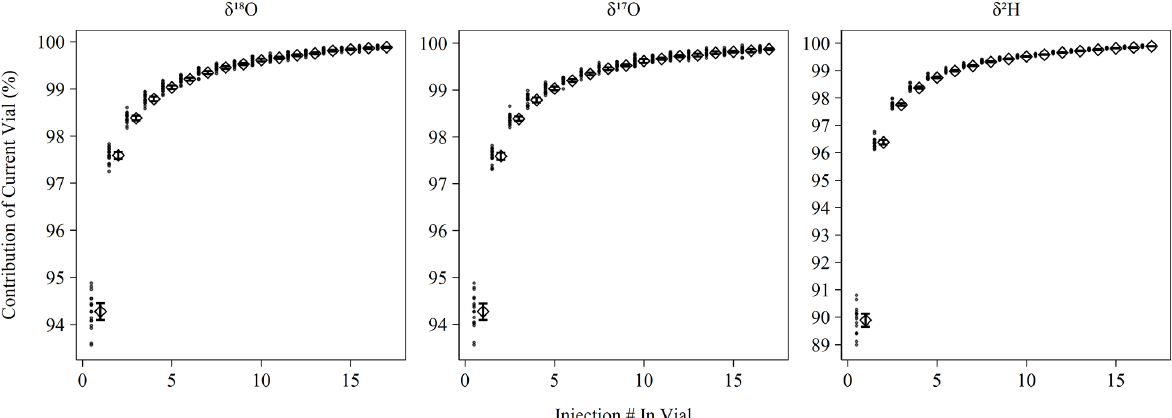
Figure 1. Percent contribution of the current vial’s injection to the observed isotopic measurement based on memory term sequences (Sect. 2.2). Long-term mean and 95% bootstrapped confidence interval shown as diamonds and error bars, respectively, with contribu- tion estimates from individual memory coefficient runs shown as filled circles. Note that δ 18 O and δ 17 O have different y axis ranges than δ 2